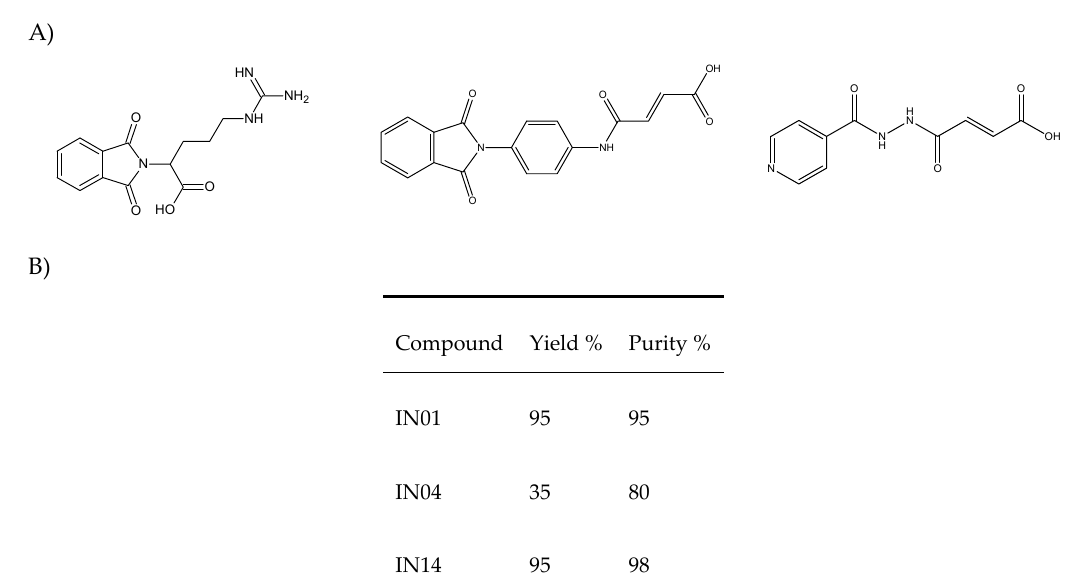
Figure 1. ( A ) Chemical structures of compounds IN01 (left), IN04 (center) and IN14 (right). ( B ) Yield and purity of the new histone deacetylases (HDAC) inhibitors synthetized.